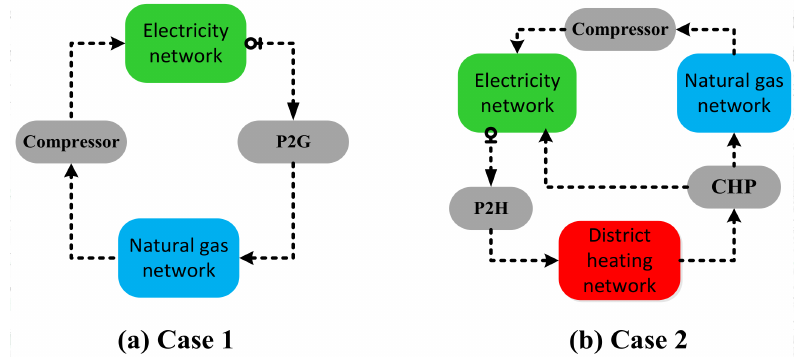
Figure 18. Schematic diagram of uncertainty transmission among the